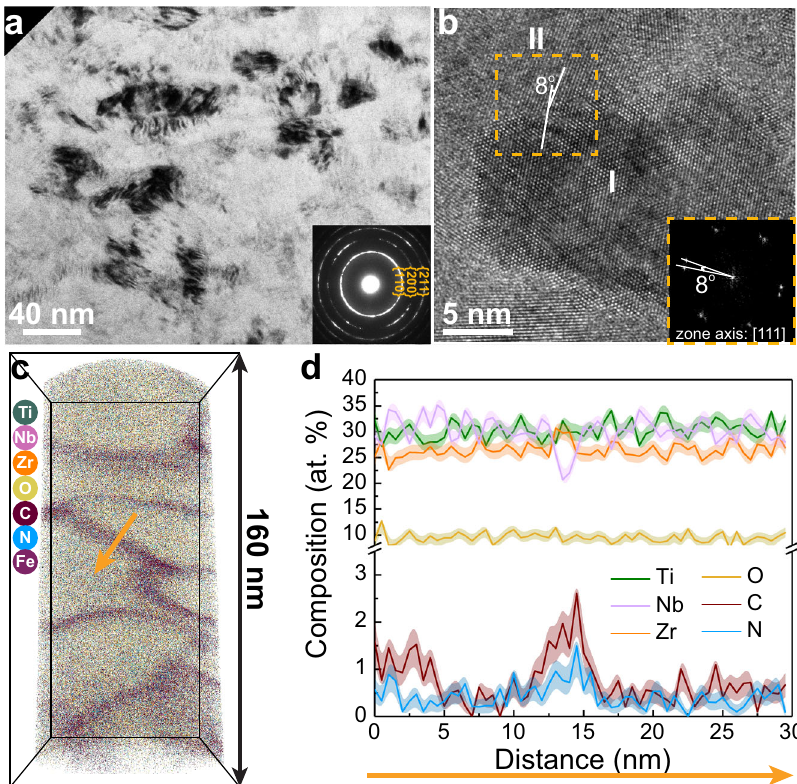
Fig. 4 Deformation mechanisms of the O-12 MISS alloy. a A side-view TEM image of the O-12 MISS alloy upon 65% compressive strain, showing that the grains have been re fi ned. The inset image is the corresponding SAED pattern. b A representative HRTEM image of the deformed structure containing two grains (labeled as I and II) observed along the [111] zone axis. The inset is the FFT pattern of the rectangle region in b , indicating an 8° misorientation between the two abutting grains. c Three-dimensional reconstruction of a typical APT specimen taken from the deformed material, revealing the grain boundary shape change after deformation. d 1D compositional pro fi le measured by APT along the arrow displayed in c . The composition of the grain boundaries is similar to those in the as-fabricated O-12 MISS